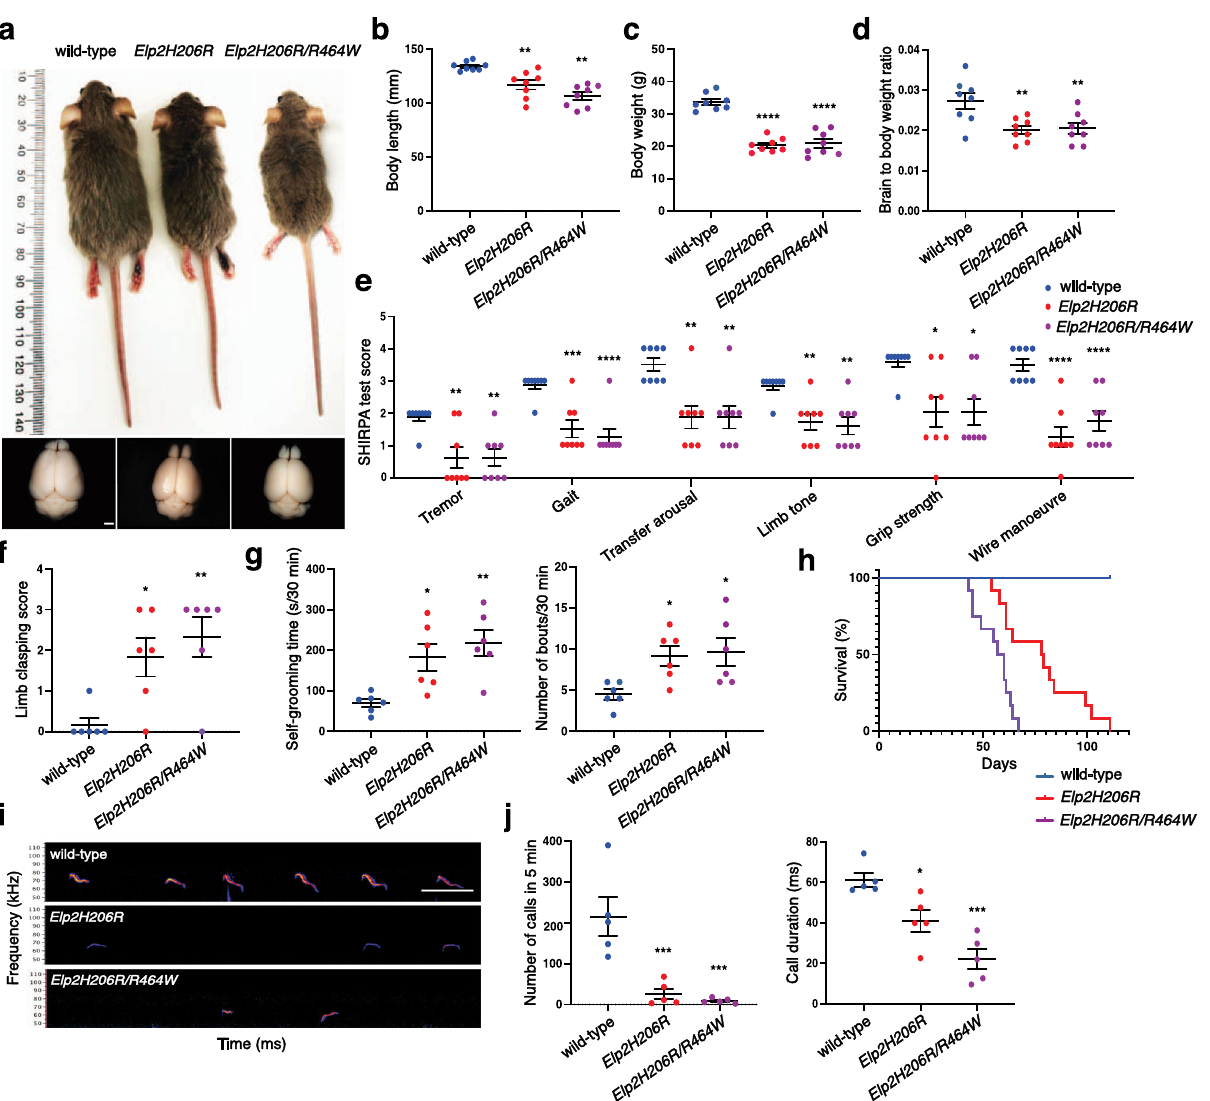
Fig. 4 Developmental delay, microcephaly, motor defects, and autistic features in Elp2H206R and Elp2H206R/R464W mice. a Appearance of an Elp2H206R homozygous and Elp2H206R/R464W compound heterozygous mouse on DBA2/J genetic background and the control littermate (upper panel), as well as their dissected brains (lower panel) at postnatal day 60 (P60). b Body length, c weight, and d relative brain weight of the indicated genotypes were quanti fi ed at P60. e Signi fi cant effects of Elp2H206R and Elp2H206R/R464W on scores for SHIRPA test at P60. f Abnormal hindlimb clasping and g repetitive self-grooming (recorded for 30 min in a home cage) shown as prolonged self-grooming time and increased number of self-grooming bouts in P60 Elp2 mutant mice vs. control littermates. For ( a – e ) n = 8 (four males and four females), for ( f ) and ( g ) n = 6 (three males and three females). h Kaplan – Meier curve of mouse survival ( n = 12). i Representative spectrograms of ultrasonic vocalizations emitted upon separation of juvenile wild-type, Elp2H206R and Elp2H206R/R464W mouse pups from their nests at P7. j Total number and duration of ultrasonic vocalization call emitted during a 5-min recording interval ( n = 5 mouse pups per genotype). Scale bars, 2 mm ( a ) and 100 ms ( i ). Statistical analysis: one-way ANOVA ( α = 0.05) with a Dunnett ’ s post-hoc test. Statistically signi fi cant differences are indicated (* p ≤ 0.05; ** p ≤ 0.01; *** p ≤ 0.001; **** p ≤ 0.0001). Data represent mean ± SEM. Source data are provided as a Source Data fi